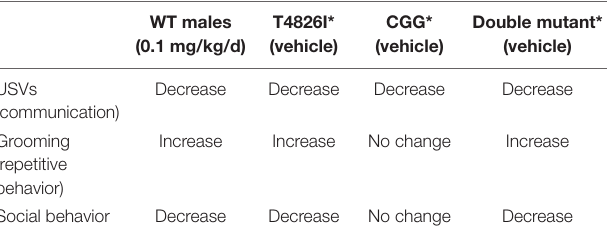
TABLE 1 | Summary of PCB and genotype effects on behavior compared to wildtype (WT) vehicle control mice. WT males (0.1